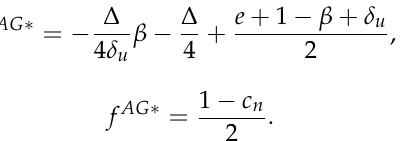
regarding β , δ u , c n , c r , s, and f .